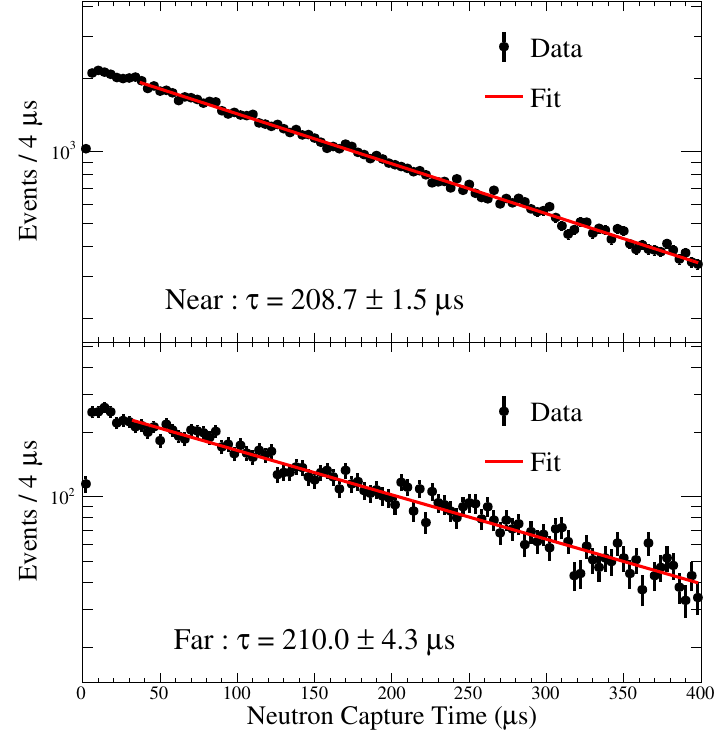
Figure 15 . Measured time distributions of neutron capture on hydrogen. The mean capture time is (cid:24) 200 (cid:22) s from the best (cid:12)t and consistent between the near and far detectors within uncertainties. The total background rate is estimated to be 18.13 (cid:6) 0.51 (24.37 (cid:6) 0.24) events per day in the near (far) detector, respectively. The total background fractions are 4.94 (cid:6) 0.14% in the near detector, and 37.53 (cid:6) 0.38% in the far detector. The observed rates of IBD and background are summarized in table 3.